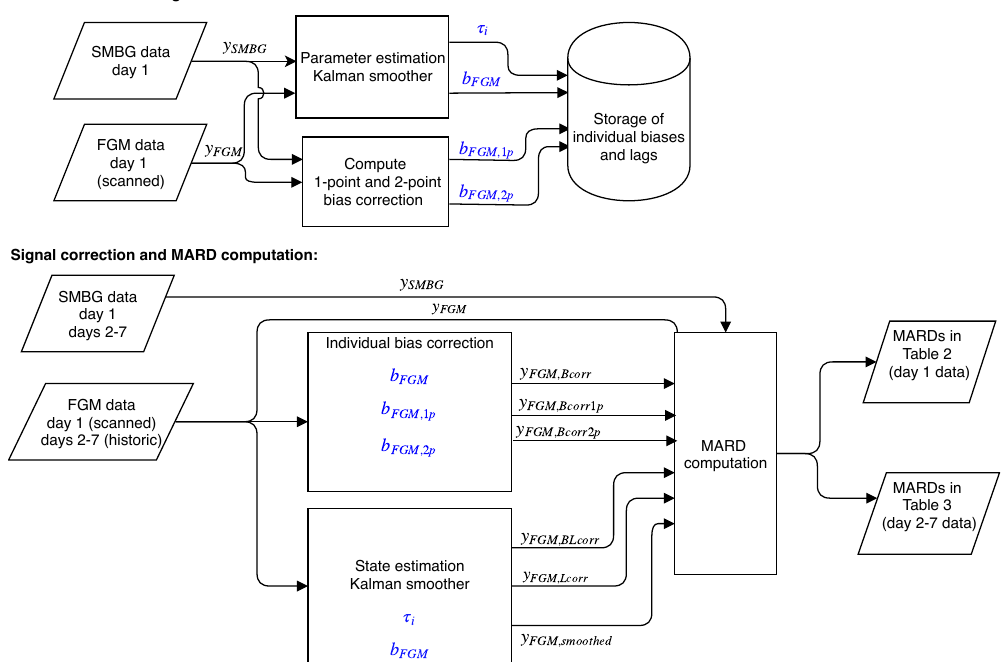
Figure 2. An overview of the signal processing. Items in blue are individual parameters estimated from day 1 data, and used to correct both day 1 and days 2–7 data for that individual. The parameters and signals shown are described in the main text, Section